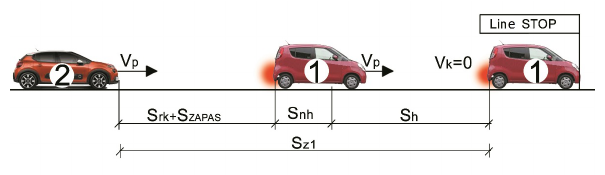
Figure 5: Diagram of the distance of the car following No. 2 behind the braking suddenly, abruptly preceding car No. 1